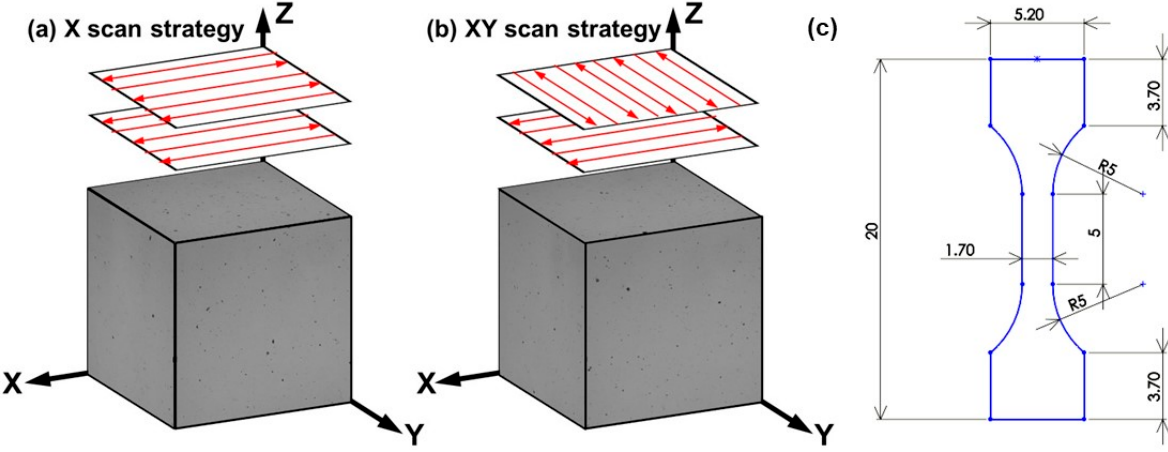
Figure 2. Three-dimensional OM images and the dimensions for the tensile test of the samples ( a ) X- and ( b ) XY-scan strategies; ( c ) the dimensions of the tensile test sample.